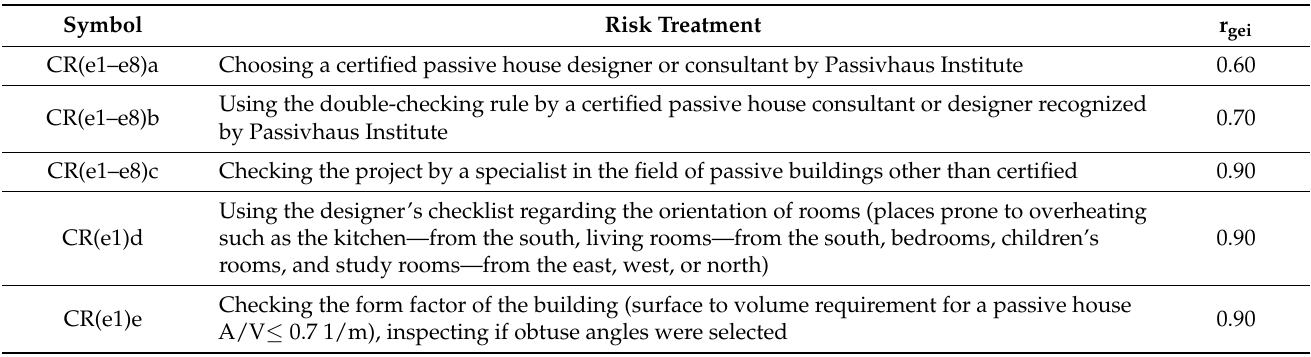
Table 5. Risk treatment possibilities for passive building